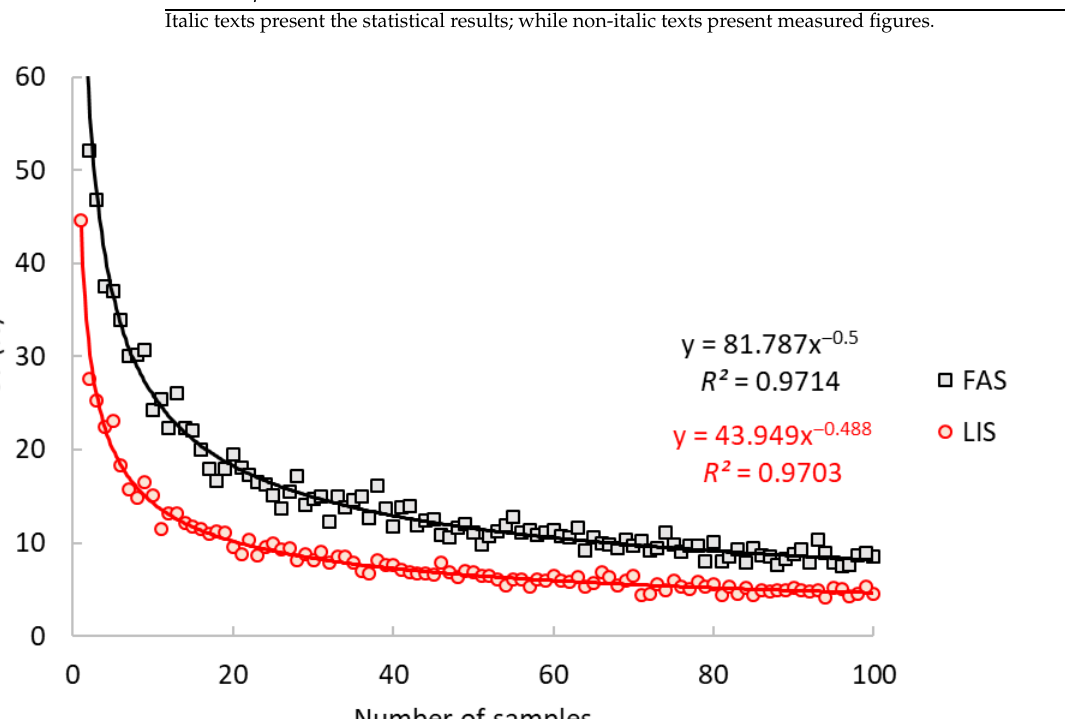
Figure 3. Sampling simulations from 1 to 100 plots for the Pilot Stand, and corresponding coefficient of variation (CV) of the estimated volume of pieces from 0 to 4 cm in diameter for the fixed-area sampling methods (FAS: black squares, quadrats of 0.46 m 2 ) and line-intersect sampling method (LIS: red circles, 0.7 m transects). Mean of 100 simulations for each number of samples (squares and circles) and the adjusted model (solid lines).